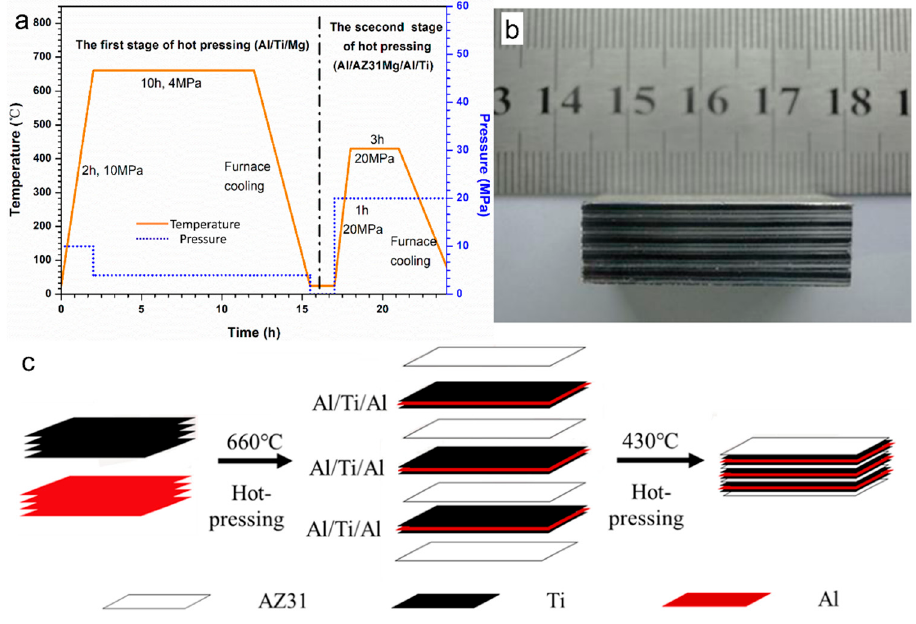
Figure 1. The preparation process of AlMgTi-based metal–intermetallic laminated (MIL) composites: ( a ) Step hot pressing process; ( b ) AlMgTi-based micro laminated material sample; ( c ) Schematic diagram of preparation process.